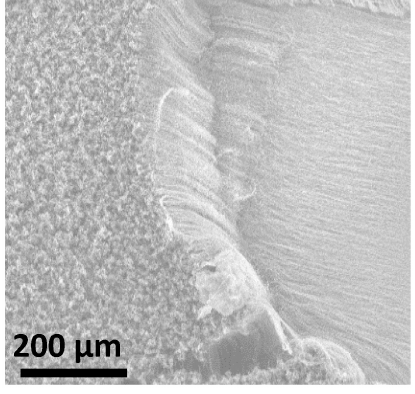
Figure 1. Scanning electron micrography (SEM) images of the supported carbon nanotube (CNT) after growing (left area: CNT; right area: quartz substrate)